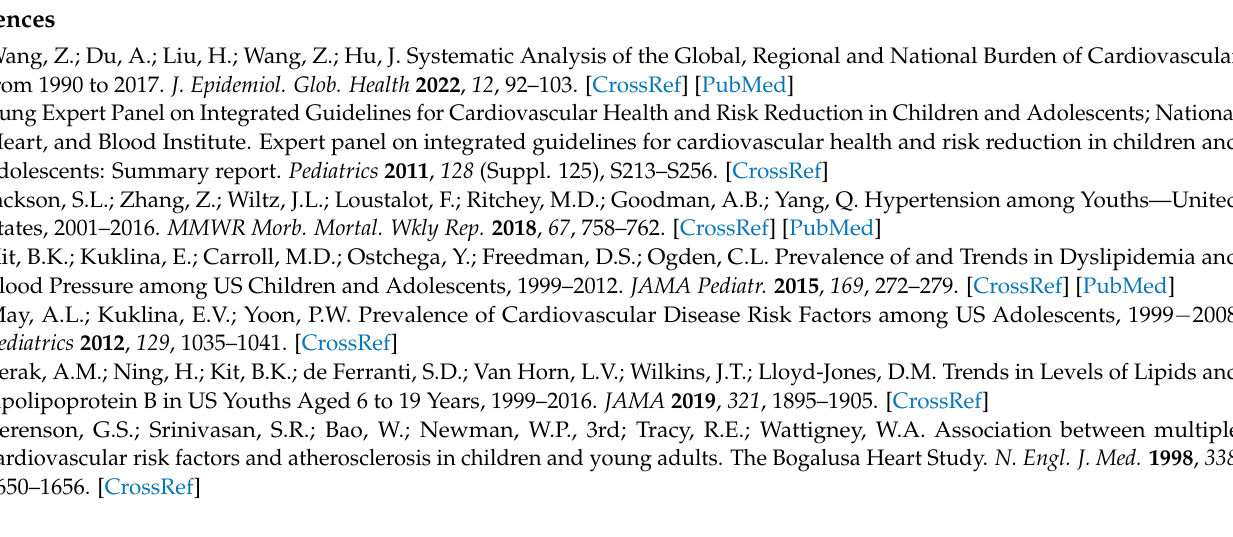
the sample. Figure S1: Associations between hypertension, impaired fasting glucose and birth weight stratified by age and sex groups; Figure S2: Associations between dyslipidemia, abdominal obesity and birth weight stratified by age and sex groups; Figure S3: Associations between clustered CMRFs and birth weight stratified by age and sex groups; Figure S4: Associations between hypertension, impaired fasting glucose and lifestyle stratified by age and sex groups; Figure S5: Associations between dyslipidemia, abdominal obesity and lifestyle stratified by age and sex groups; Figure S6: Associations between clustered CMRFs and lifestyle stratified by age and sex groups; Figure S7: Associations between hypertension, impaired fasting glucose and combinations of birth weight and lifestyle stratified by age and sex groups; Figure S8: Associations between dyslipidemia, abdominal obesity and combinations of birth weight and lifestyle stratified by age and sex groups; Figure S9: Associations between clustered CMRFs and combinations of birth weight and lifestyle stratified by age and sex